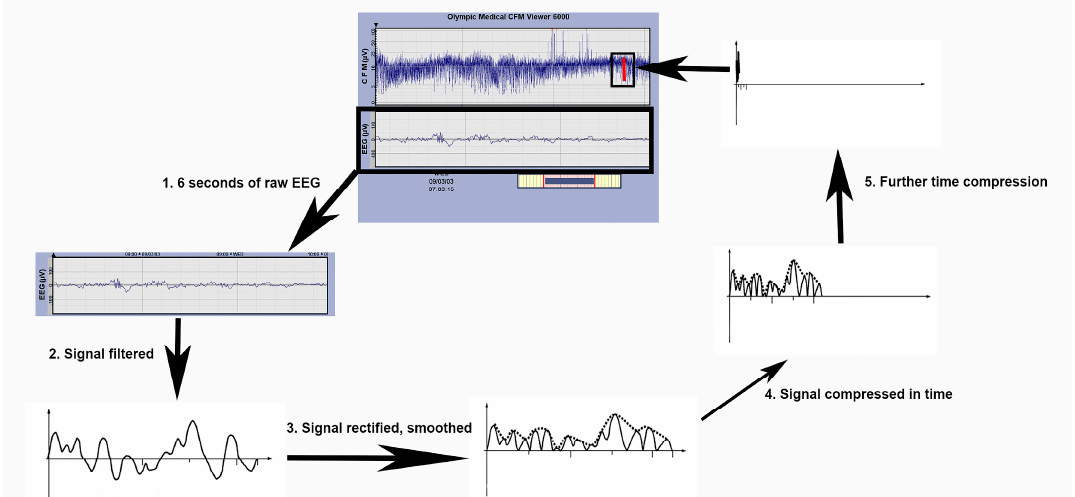
Figure 3. The aEEG derives a tracing from the raw EEG. In step 1, six seconds of the raw EEG is extrapolated. In step 2, the signal is filtered. The filtering includes an asymmetric band pass filter that attenuates activity below 2 Hz and above 15 Hz. In step 3, the signal is rectified and smoothed. Note the negative inflections are converted to positive inflections. In steps 4, 5, and 6 the signal undergoes a series of time compressions. The time compressions steps then lead to a single line. Multiple lines then form a pattern for interpretation. The amplitude display on the bedside monitor is linear between 0 to 10 µV and logarithmic between 10 to 100 µV (Derived from [29]).